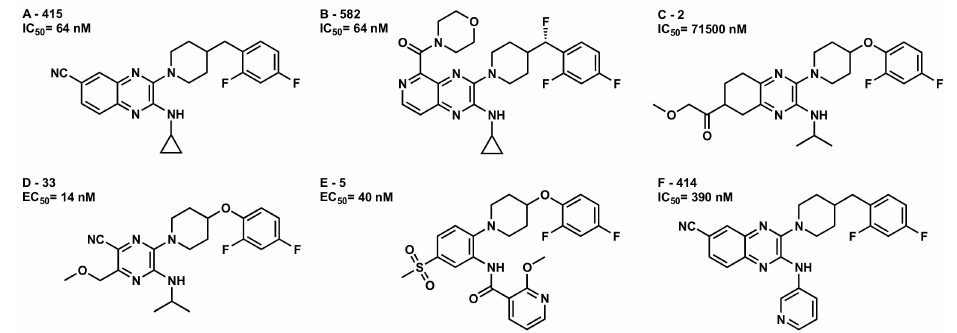
Figure 6. GPR6 modulators—Pyrazine analogs used for docking studies. The numbers next to the alphabetic letter for each compound come from Envoy Therapeutics, Inc. and Takeda Pharmaceutical Company